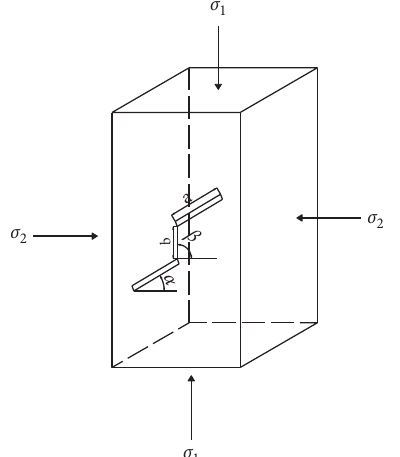
Figure 4: Diagram of specimen loading. α -Fissure dip angle, β -rock bridge dip angle, a-fissure length, b-rock bridge length, σ σ 2 -lateral